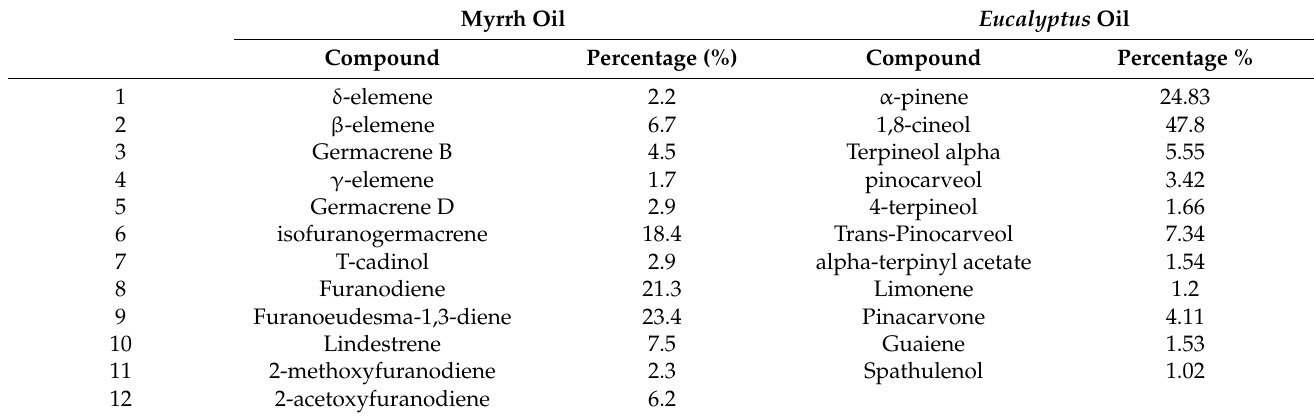
Table 1. Content compounds identified (%) of Eucalyptus and Myrrh